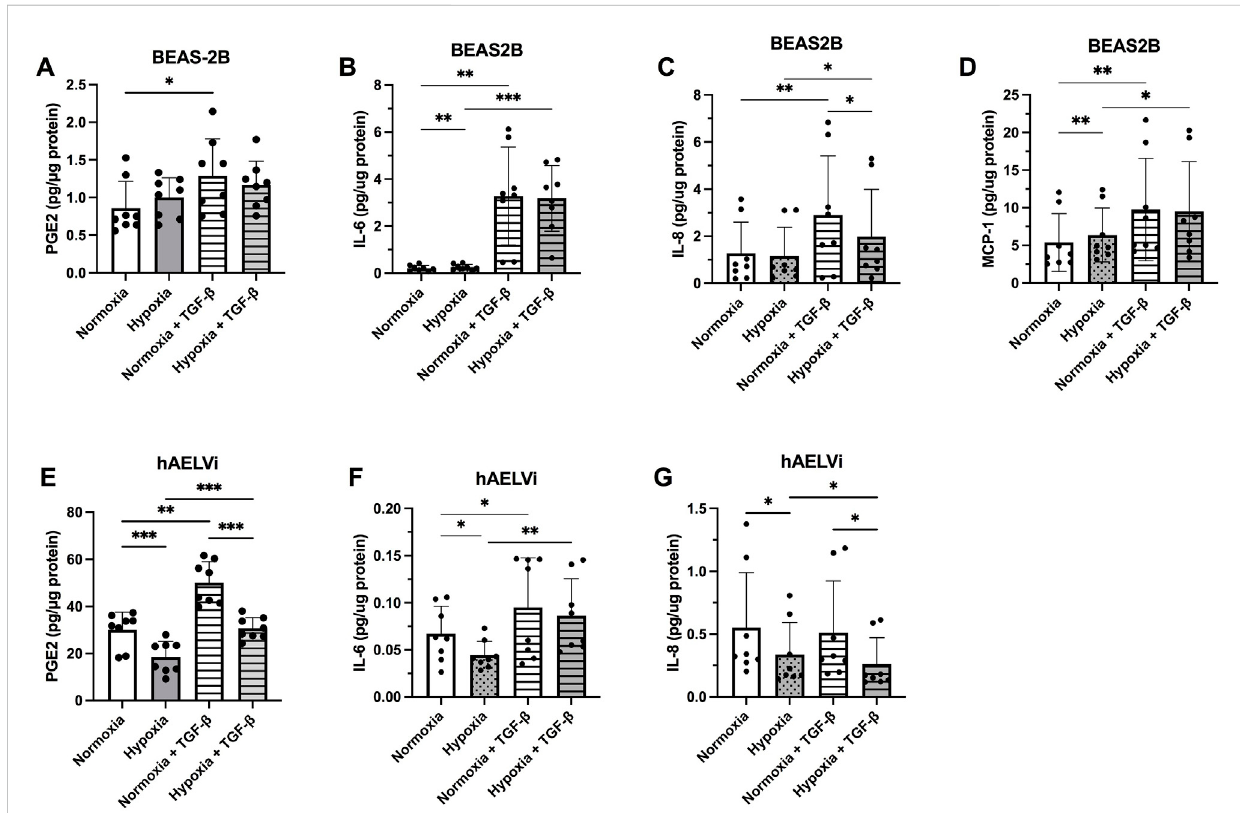
FIGURE 5 Release of the in fl ammatory mediators prostaglandin E 2 (PGE 2 ) (A,E ), Interleukin (IL)-6 (B,F ), IL-8 (C,G) and Monocyte chemoattractant protein (MCP)-1 (D) from BEAS-2B (A – D) and hAELVi (E – G) cells 24 h post hypoxia exposure, with or without 10 ng/mL of TGF- β 1 stimulation. The amount of cytokines was normalized to the total protein concentration amount. All data is from four individual experiments with two biological replicates in each experiment ( n = 8 in total). The data is presented as mean ± SD. Statistical analysis was performed using One-way ANOVA and LSD ’ s multiple comparison post-hoc test. * p < 0.05, ** p < 0.01, *** p < 0.001, **** p <